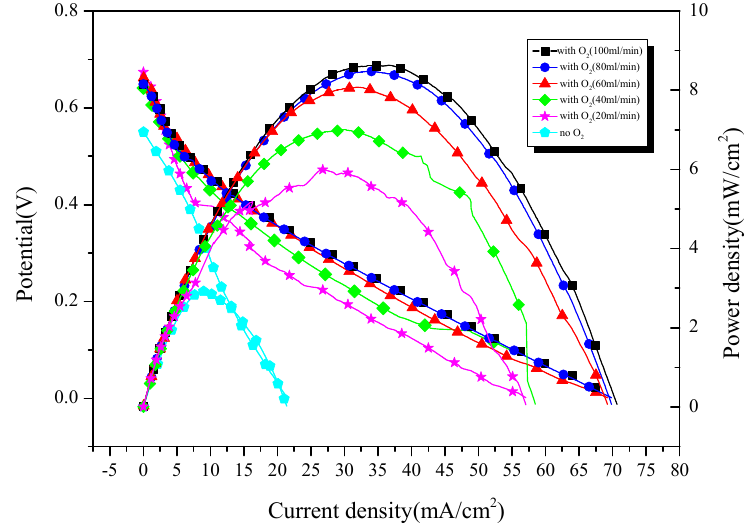
Figure 10. Polarization curve of DMFC under different oxidants.